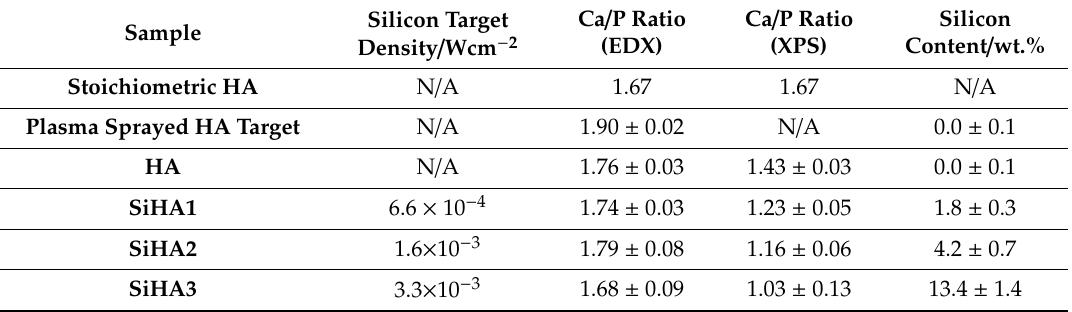
Table 1. A summary of combined silicon content of HA and SiHA thin films batches as measured by EDX. Values displayed are the mean ± standard error of the mean, where n = 6. Ca / P content calculated from EDX and XPS